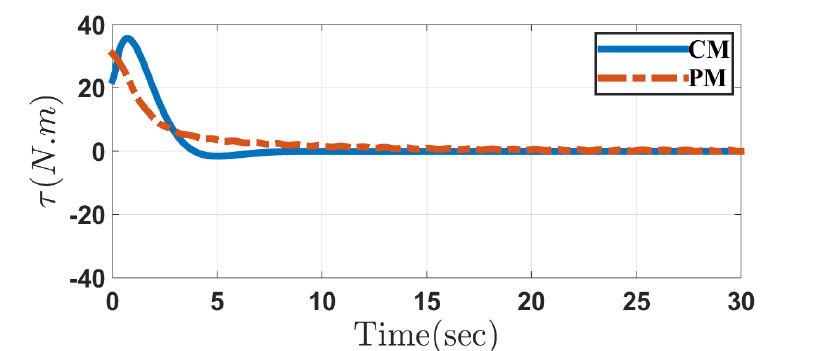
Figure 17. Input torque of the wheels in the conventional method (CM) and the proposed method (PM) in Case 2.